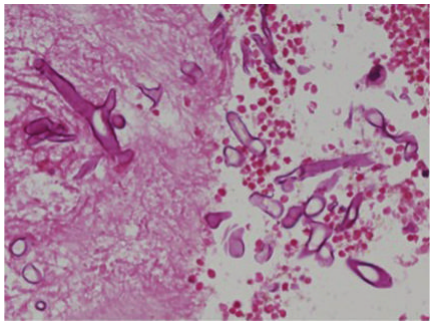
Figure 3: Histopathology slide demonstrating broad nonseptate hyphae in longitudinal (upper left) and cross-sectional (right) pro- files. Eosin and Hematoxylin stain. Original magnification ×